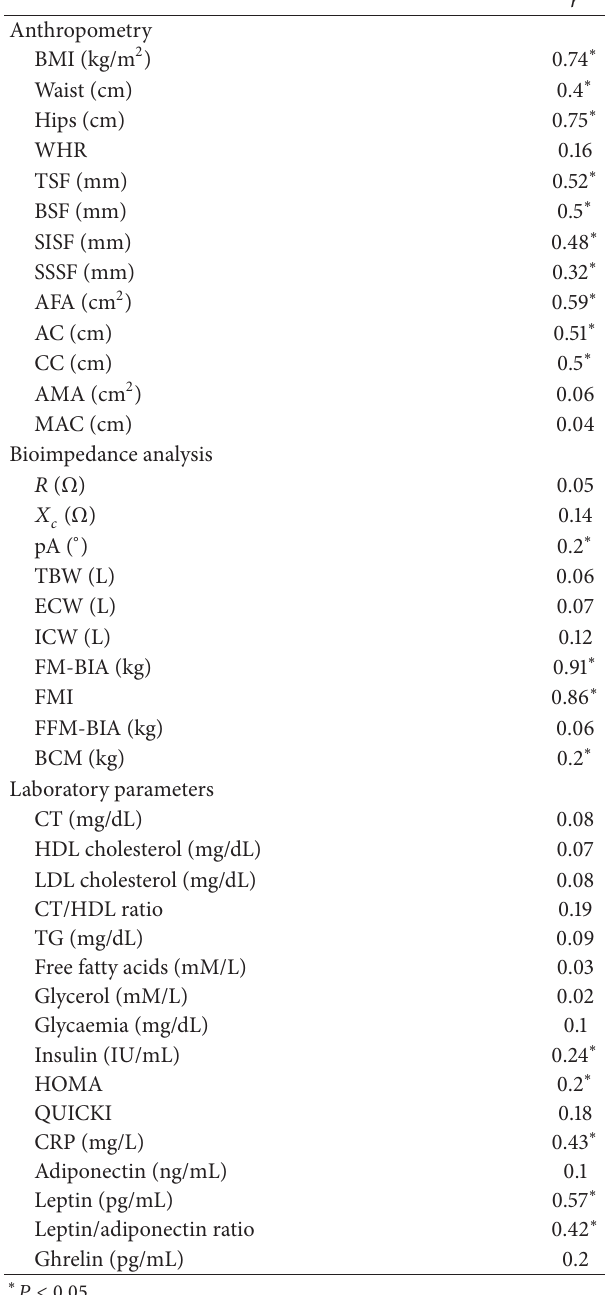
Table 3: Univariate analysis: correlation between FM from DXA and anthropometry, bioimpedance, and laboratory